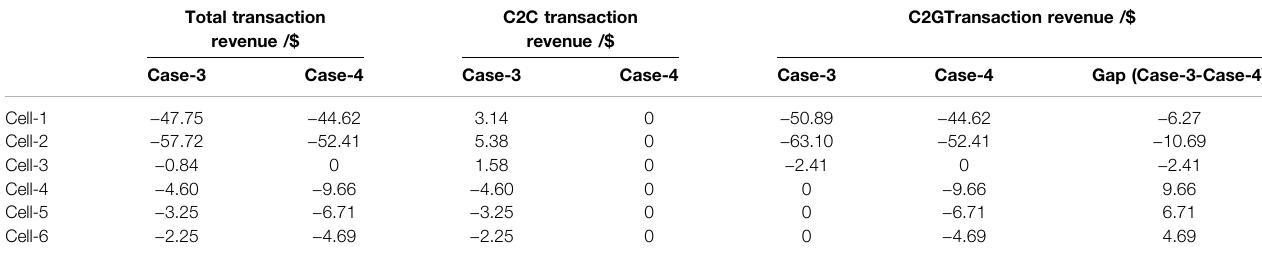
TABLE 5 | Transaction revenues for each Cell in Case-3 and Case-4 at that